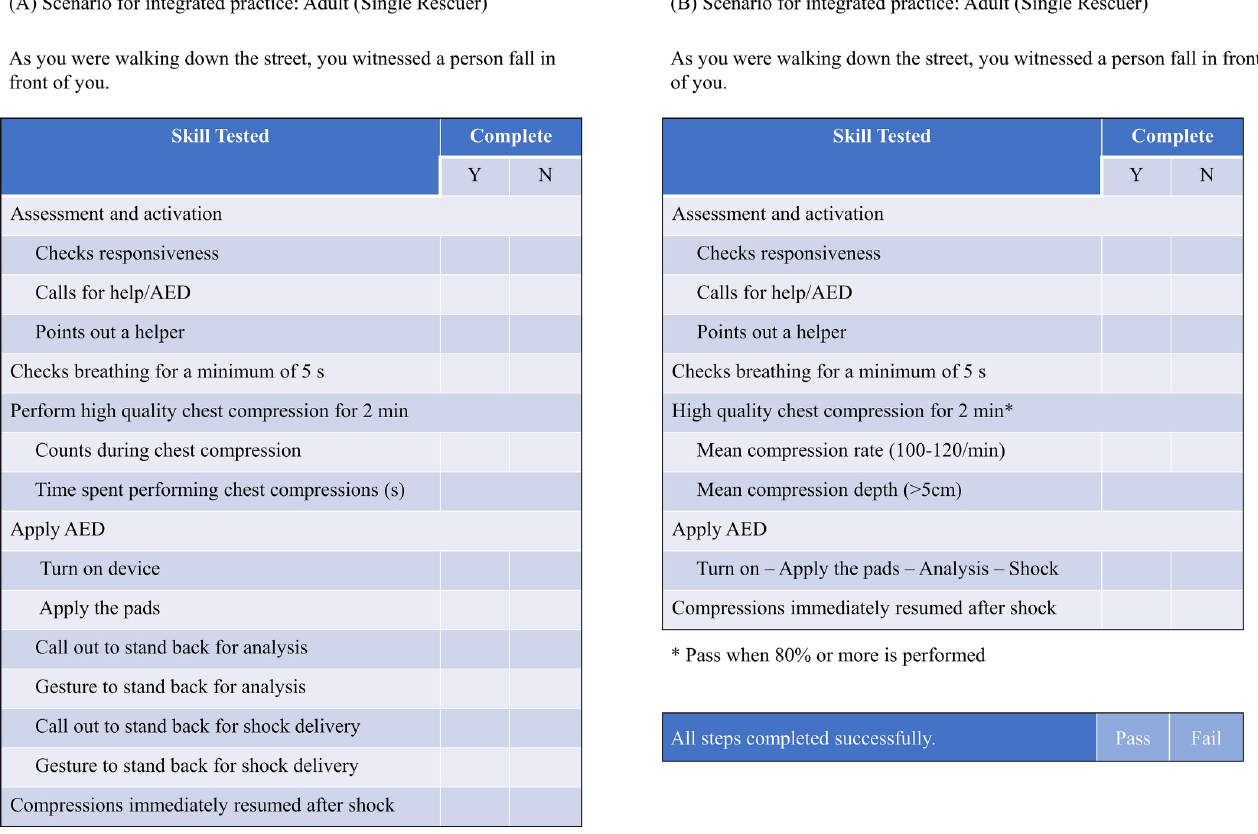
Fig 1. Scenario and checklist of integrated practice for an adult case with a single rescuer. (A) and (B).